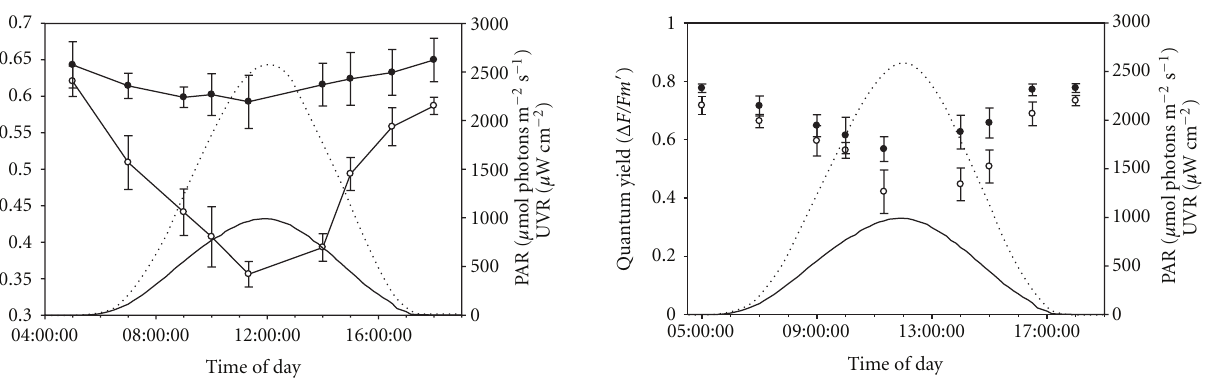
Figure 4: Daily changes in the absorption cross section (or absorption factor, AF) of plants grown on the water table for 14 days under control filters (open circles) or UV filters (closed circles), and PAR (400–700 nm) measured above the plants on the water table (full line) and UVR (300–400 nm) under the control filter (dotted line; there was no measurable UVR under the UV filter). Data points of AF are means of 10 replicates ± SE.